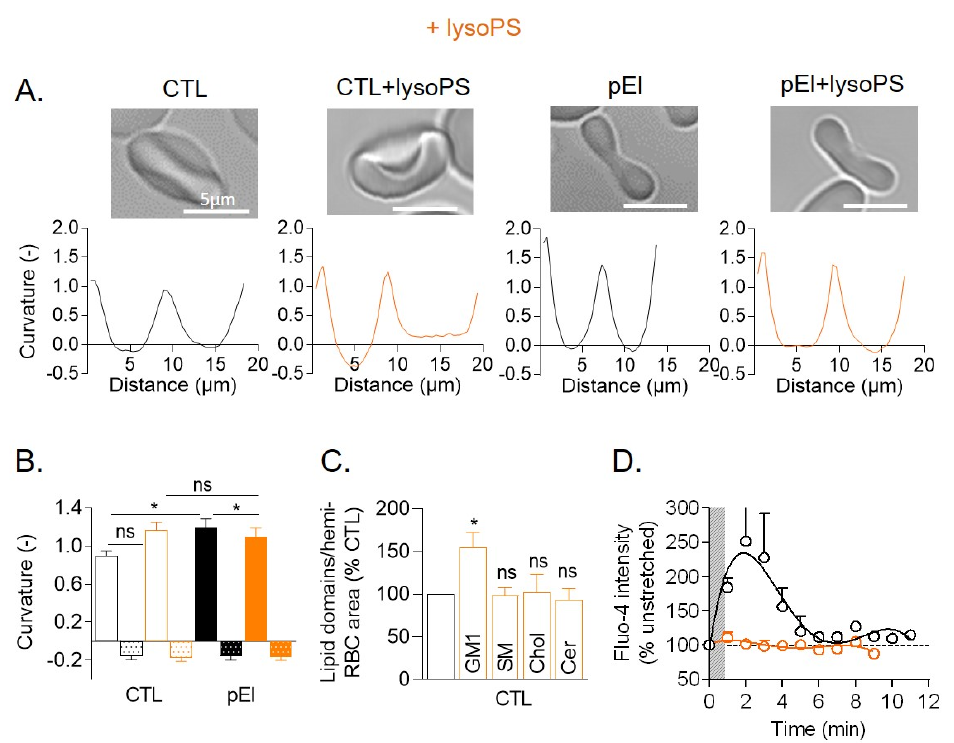
Figure 6. Membrane insertion of lysoPS in healthy RBCs increased membrane curvature and GM1-enriched domain abundance and abrogated Ca 2 + exchange. RBCs were incubated with or without 18:1 lysoPS and examined for RBC membrane curvature ( A , B ), lipid domains ( C ) and Ca 2 + exchange ( D ). ( A , B ) Membrane curvature. RBCs were laid down in IBIDI chambers and analyzed in side view for membrane curvature. The highest and lowest curvatures of each membrane curvature profile were then determined (open and dotted columns, respectively). Data are representative of 4–5 independent experiments with 6–17 RBCs analyzed per experiment. Unpaired t test to compare CTL vs. pEl and paired t test to determine the effect of lysoPS. ( C ) Abundance of lipid domains. RBCs were labeled and visualized by vital fluorescence microscopy as in Figure 3E,F. Data are means ± SEM of 4–11 independent experiments. Paired t tests. ( D ) Ca 2+ exchange after stretching in a PDMS chamber. The dotted line refers to Fluo-4 intensity of unstretched RBCs. Data are means ± SD of 2 independent experiments. ns, not significant; *, p < 0.05.